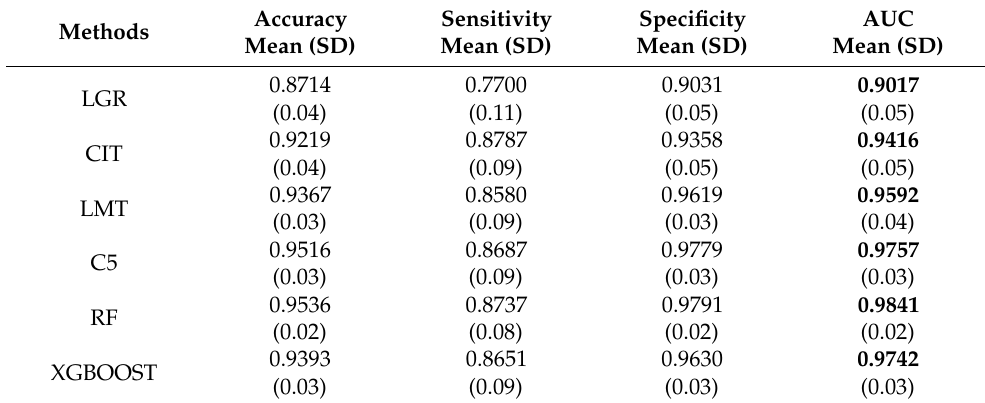
Table 5. Model performance of all methods for severe glaucoma eyes.